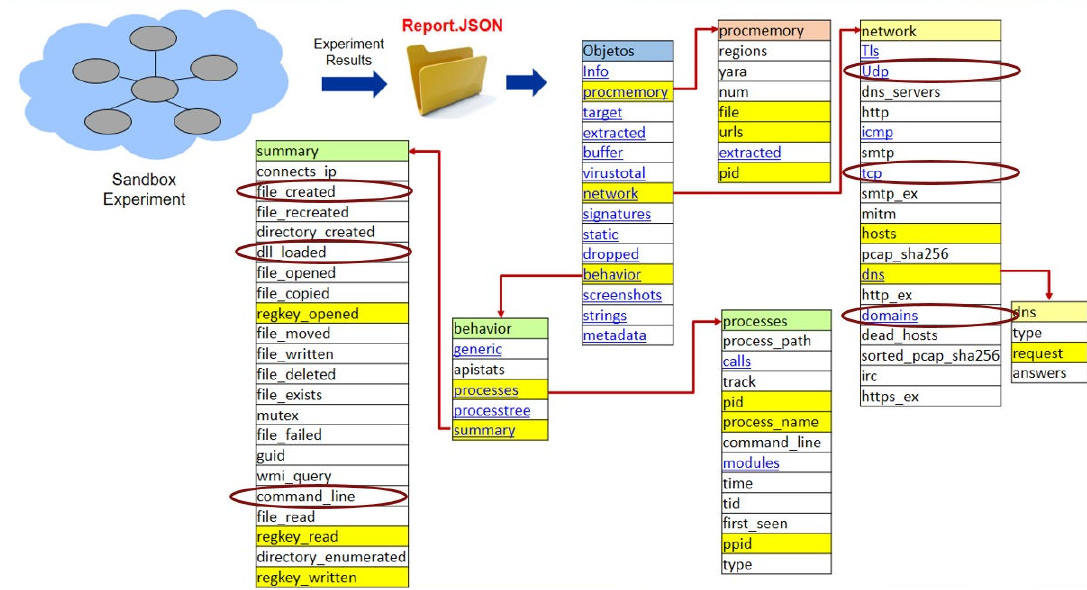
Figure 2. General structure of the JSON